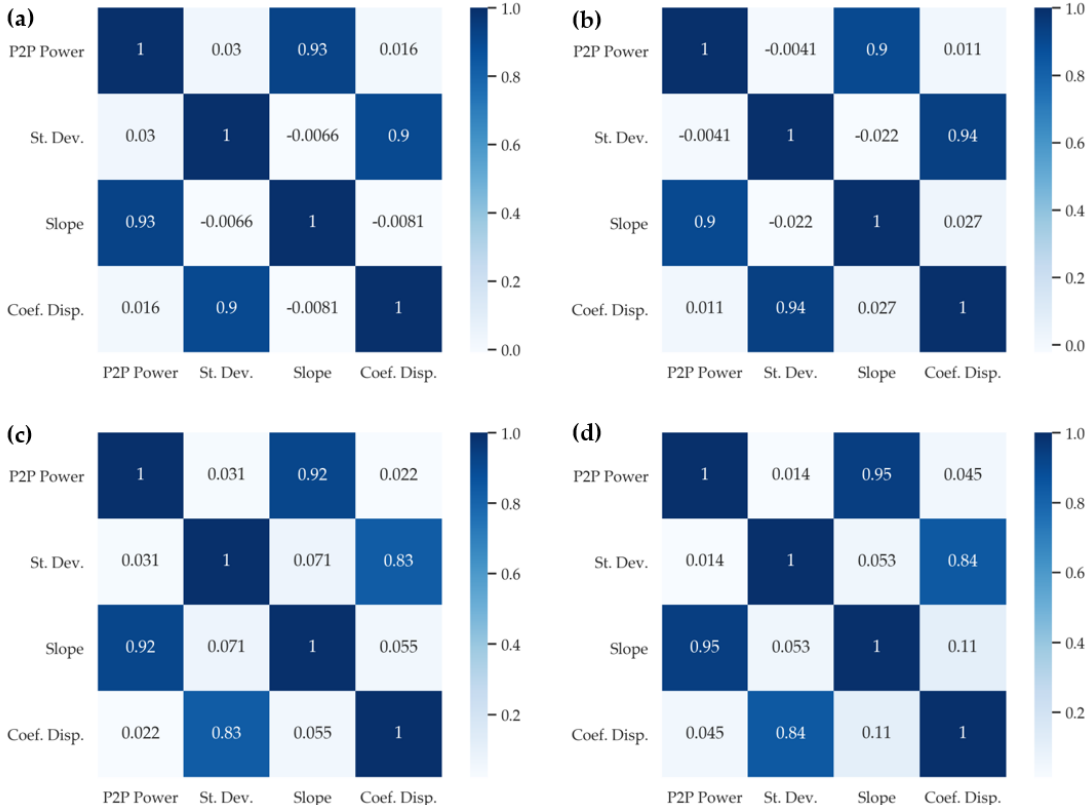
Figure 5. Correlation analysis based feature selection results for different testing households data ( a ) rf_02, ( b ) rf_31, ( c ) rf_36, ( d ) rf_42.